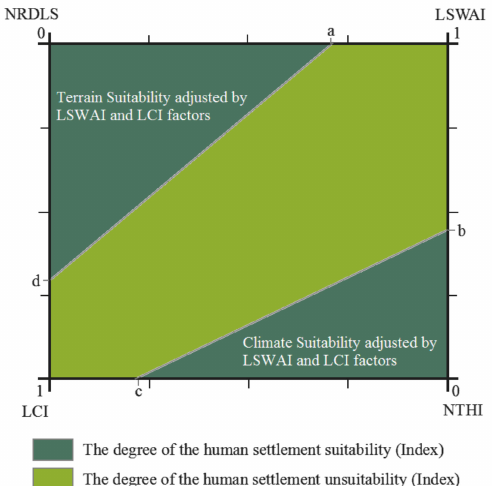
Figure 3. Schematic diagram of the spatial HSS